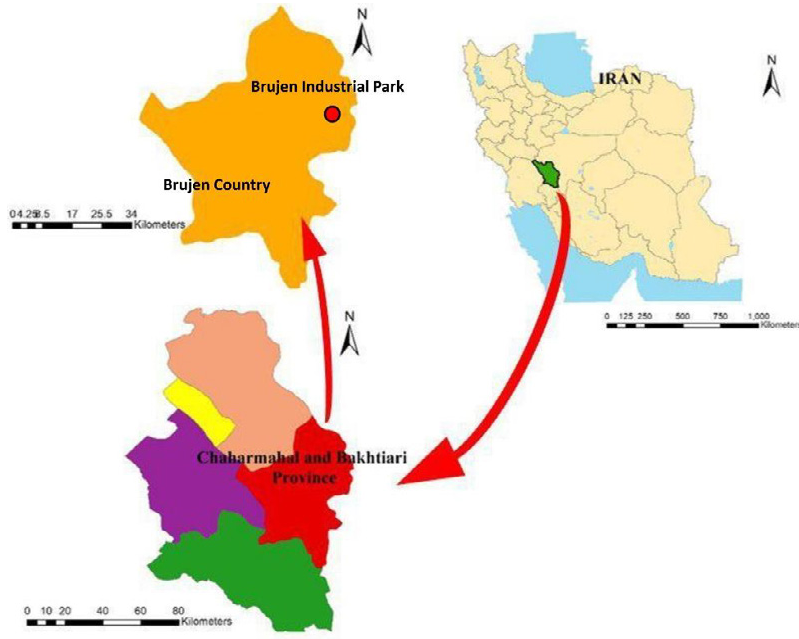
Fig. 1: Geographical location of the study area in Brujen, Iran